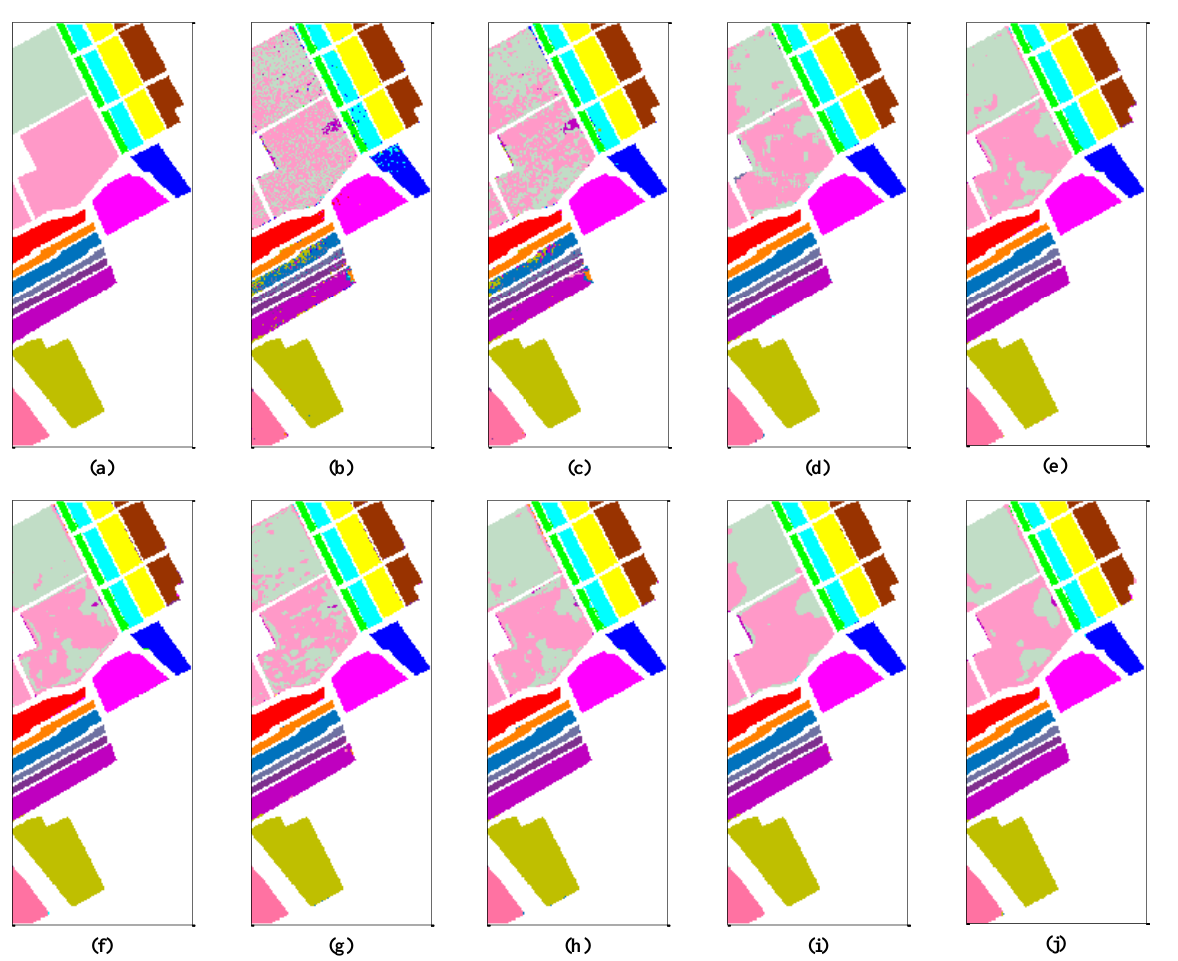
Figure 15. Land cover classification maps generated by different methods on the Salinas scene: ( a ) ground truth, ( b ) CRC, ( c ) JCRC, ( d ) CRC‑M, ( e ) JDKCRT, ( f ) KCRT‑CK, ( g ) WSSDKCRT, ( h ) WSSKCRT, ( i ) WSSJCRC, and ( j ) WSSJKCRC.